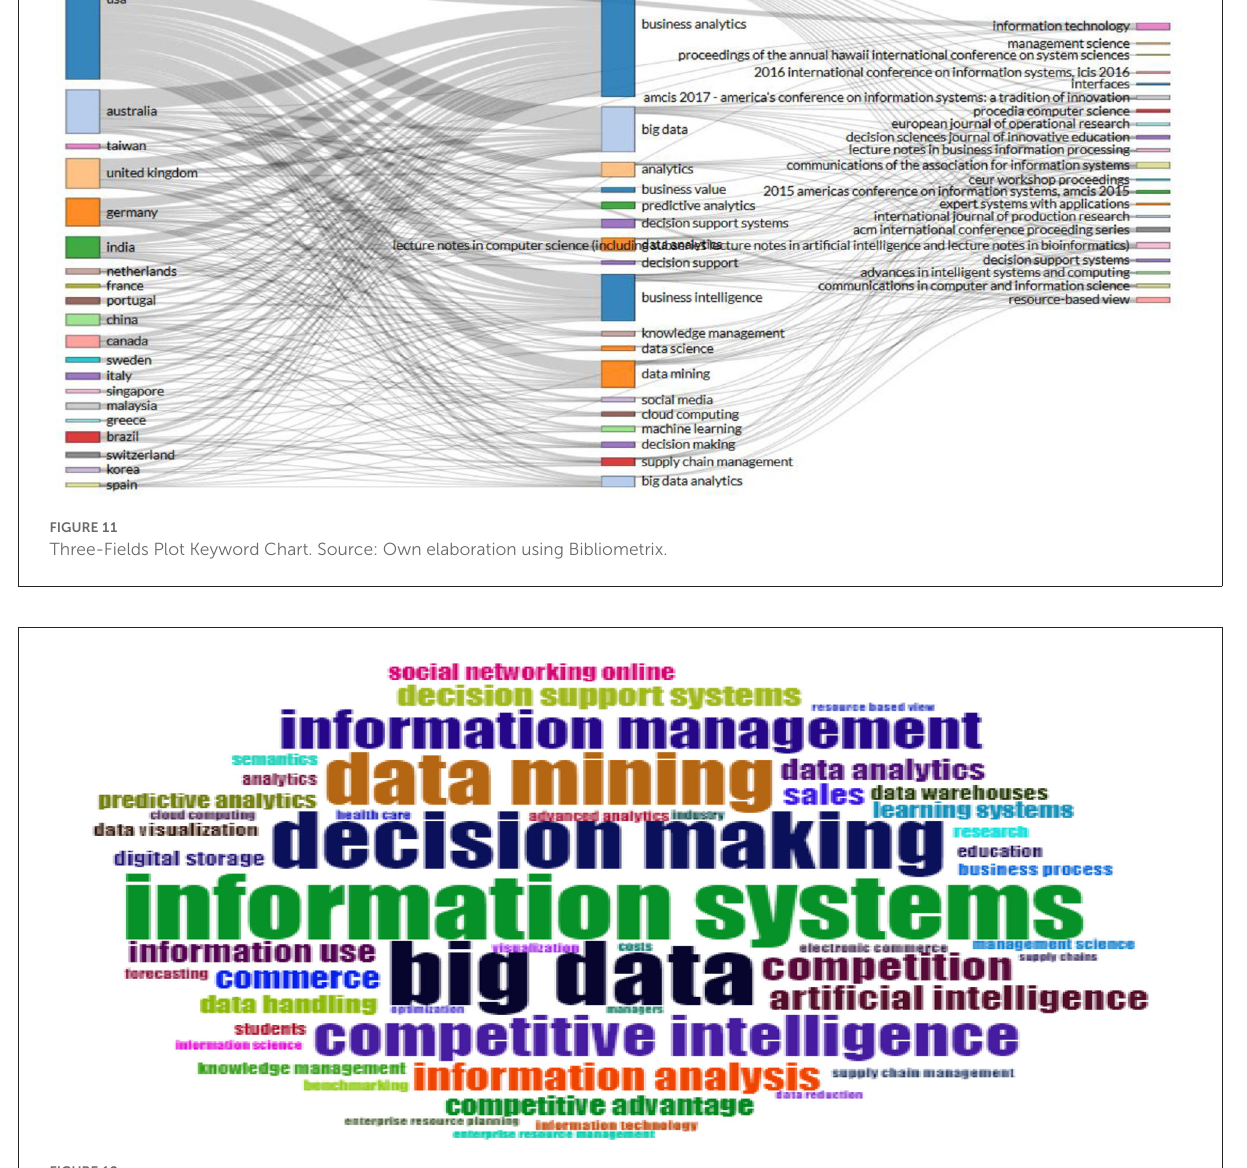
FIGURE12 Keywords. Source: Own elaboration using